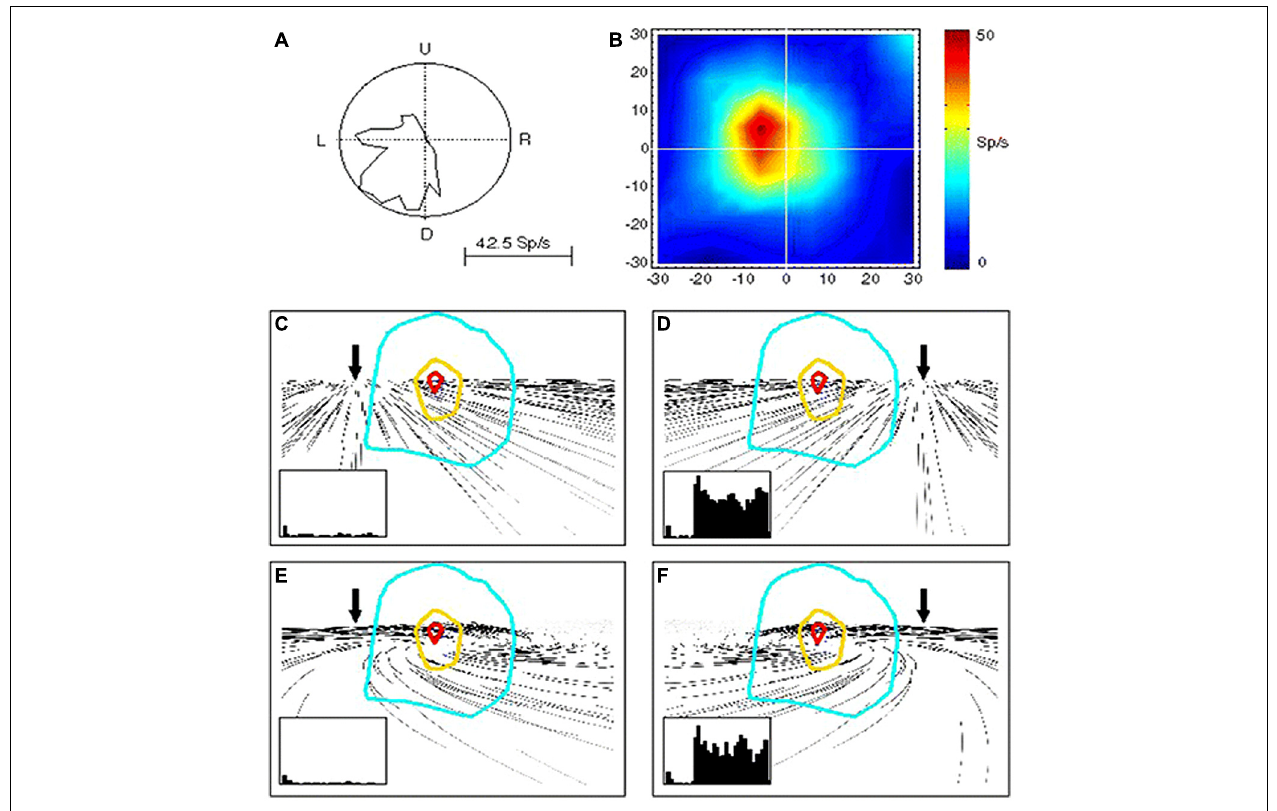
FIGURE 2 | Responses of a single MST neuron to unidirectional motion and optic flow. (A) Polar plot of the directional selectivity to left and downward motion. (B) Receptive field (RF) characterized by moving luminant bars to the left. (C–F) RF outlines on the visual flow stimuli reproducing leftward (C,E) and rightward (D,F) heading with (E,F) and without (C,D) eye